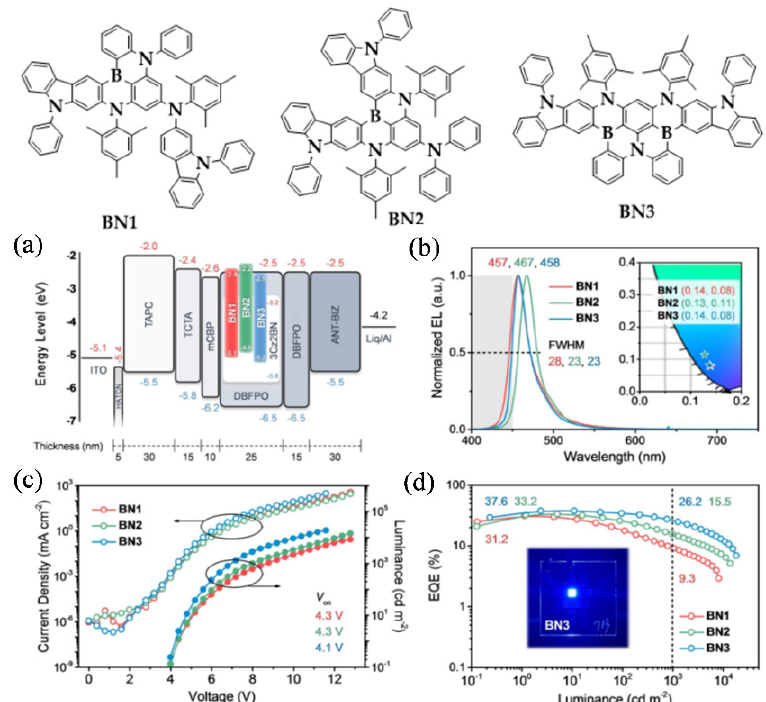
Figure 1. Molecular structures of BN1–BN3 . ( a ) Device architecture for MR-TADF OLEDs with energy level alignment of the relevant material, ( b ) EL spectra, with CIE coordinates shown in the inset, ( c ) J–V–L characteristics, and ( d ) EQE–luminance curves of MR-TADF OLEDs. Reproduced with permission from Xialei Lv, Jingsheng Miao, Meihui Liu et al., “Extending the π -Skeleton of Multi-Resonance TADF Materials towards High-Efficiency Narrowband Deep-Blue Emission”; published by John Wiley and Sons , 2022 . [45].